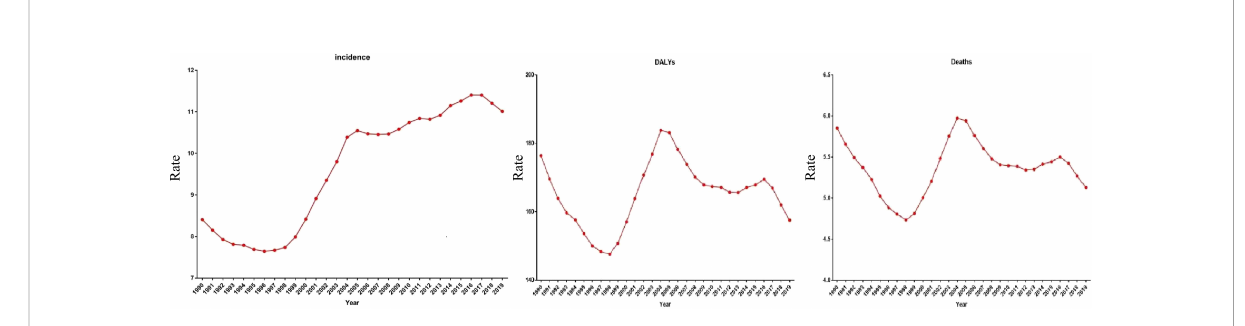
FIGURE 1 Trends of the incidence, disability-adjusted life-years (DALYs), mortality for cervical cancer 1990-2019, at all ages.